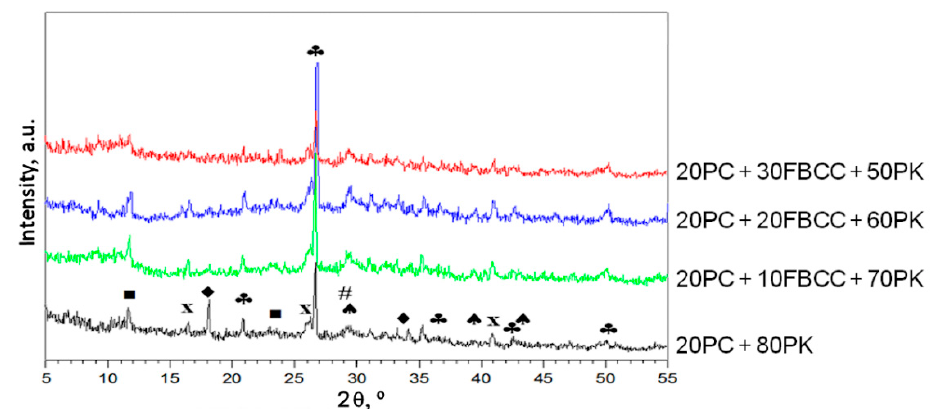
Figure 13. X-ray patterns for blended binder pastes (90th day of hydration); ♦ Ca(OH) 2 , ♣ SiO 2 , ♠ CaCO 3 , monocarboaluminate, x mullite, # C-S-H.